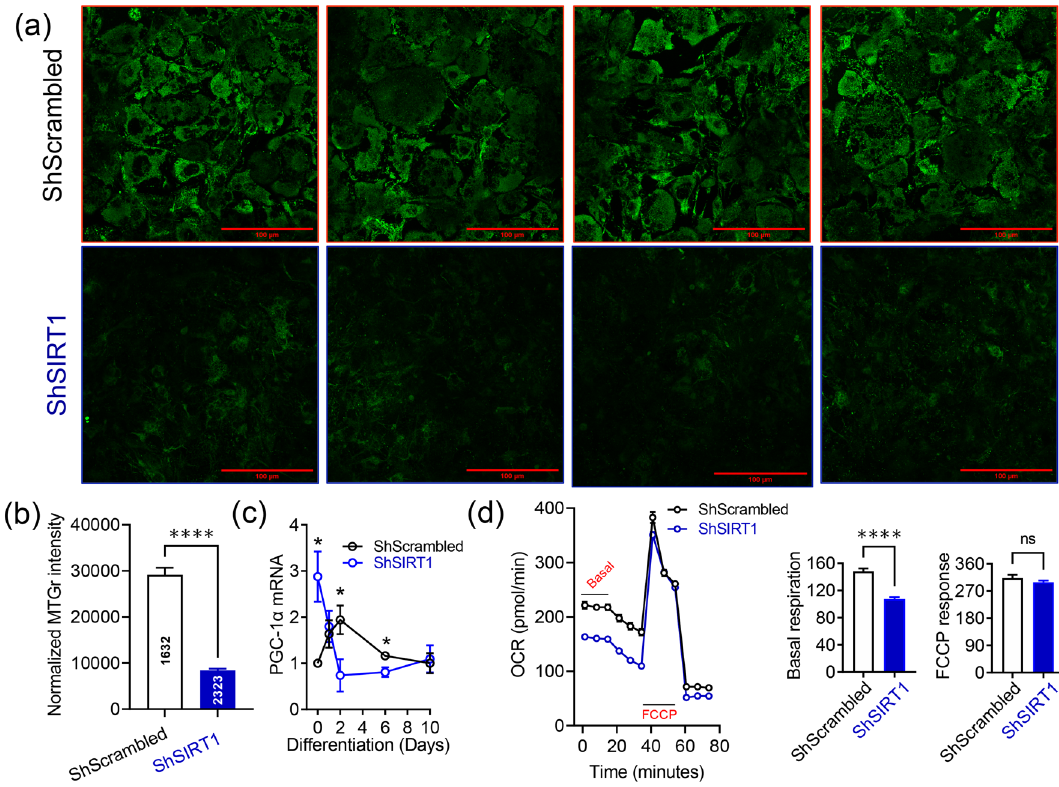
Figure 4. SIRT1 promoted mitochondrial biogenesis and respiration in 3T3-L1 adipocytes. ( a ) Representative confocal microscopy images of ShScrambled or SIRT1-depleted (ShSIRT1) adipocytes labelled with 250 nM MitoTracker Green at Day 6 post-differentiation. Scale bar 100 µm. ( b ) Quantification of MitoTracker Green staining intensity in ShScrambled or SIRT1-depleted (ShSIRT1) adipocytes (normalized to cell number) (n = 3). ( c ) Quantification of changes in the expression of PGC-1α in ShScrambled or SIRT1-depleted (ShSIRT1) (pre) adipocytes at specific time-points during adipogenesis (n = 4). ( d ) Evaluation of mitochondrial respiration parameters in ShScrambled or SIRT1-depleted (ShSIRT1) adipocytes using Seahorse technology at Day 6 post- differentiation (n = 12 biological replicates). Statistical analysis of the dataset was performed using a Student’s t test. For statistical analysis of data shown in ( c ), pair-wise comparisons were made between ShScrambled and ShSIRT1 groups for each individual time-point using the Student’s t test (*P < 0.05; ****P < 0.0001; n.s., not significant).